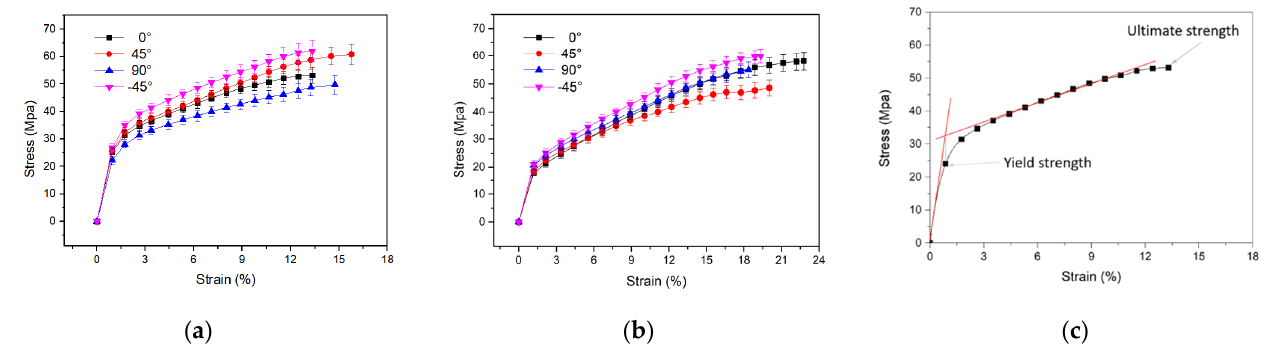
Figure 10. Typical tensile stress-strain curves of rectangular specimens cut from cocoon: ( a ) A. pernyi cocoon (H); ( b ) A. pernyi cocoon (L); ( c ) different stages in typical stress-strain curve of A. pernyi cocoon (H) in the 0 ◦